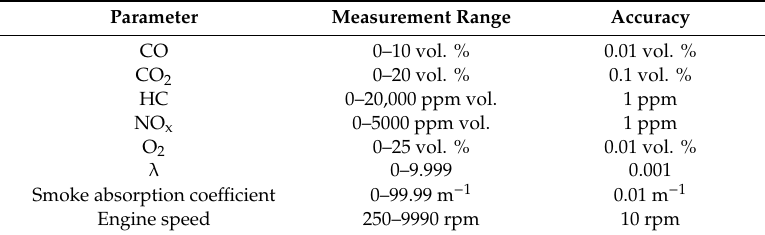
Table 3. Measurement range and accuracy of the exhaust gas analyzer.